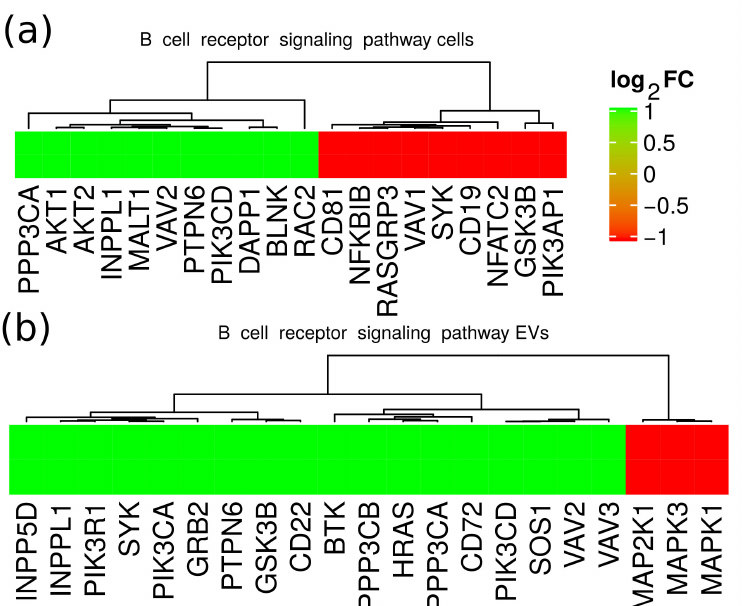
Figure A3. Log 2 fold change values for significantly regulated proteins ( p value < 0.05) associated to the B-cell receptor signaling pathway for whole cells ( a ) and for EVs ( b ). Log 2 fold change values more than two fold are represented as two fold regulated.